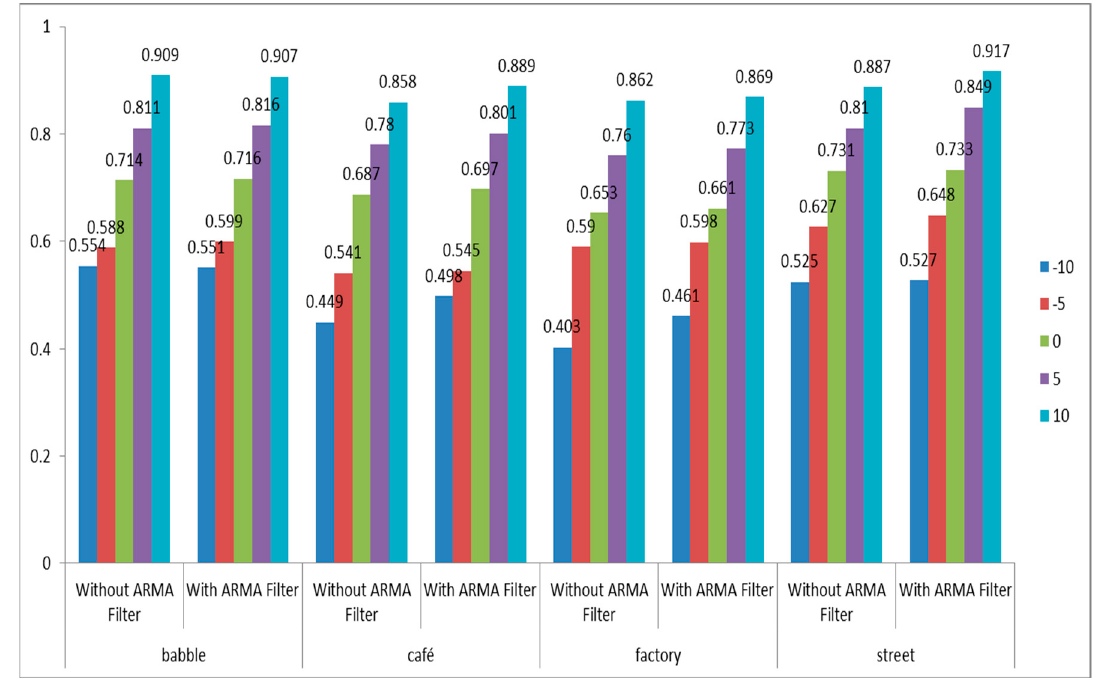
Figure 5. The impact of using the ARMA filter before decomposition via NMF.